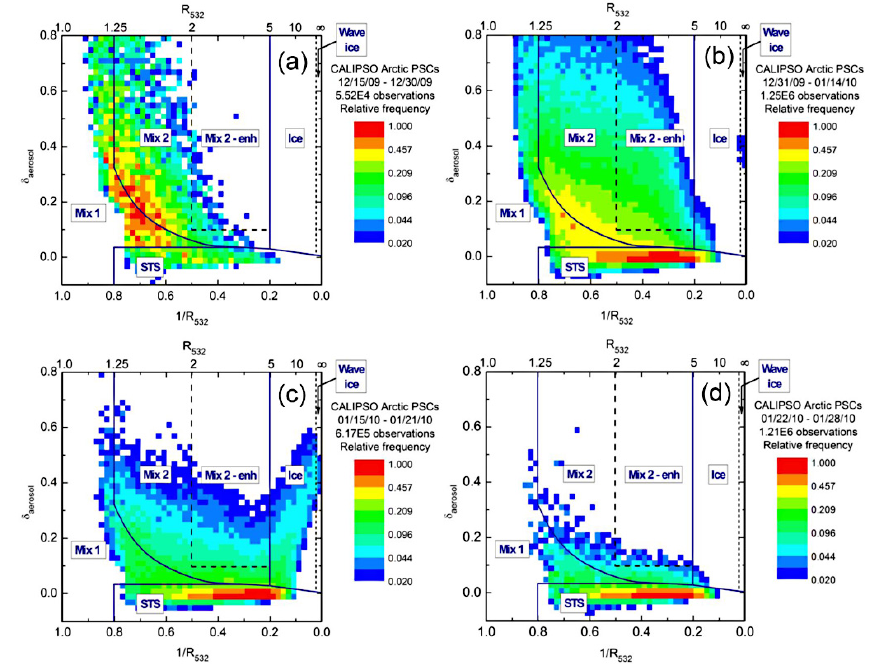
Fig. 11. Normalized composite 2-D histograms of CALIPSO PSC observations from each of four periods during the 2009–2010 Arctic winter over the altitude range from 15-30 km in the δ aerosol vs. 1/ R 532 coordinate